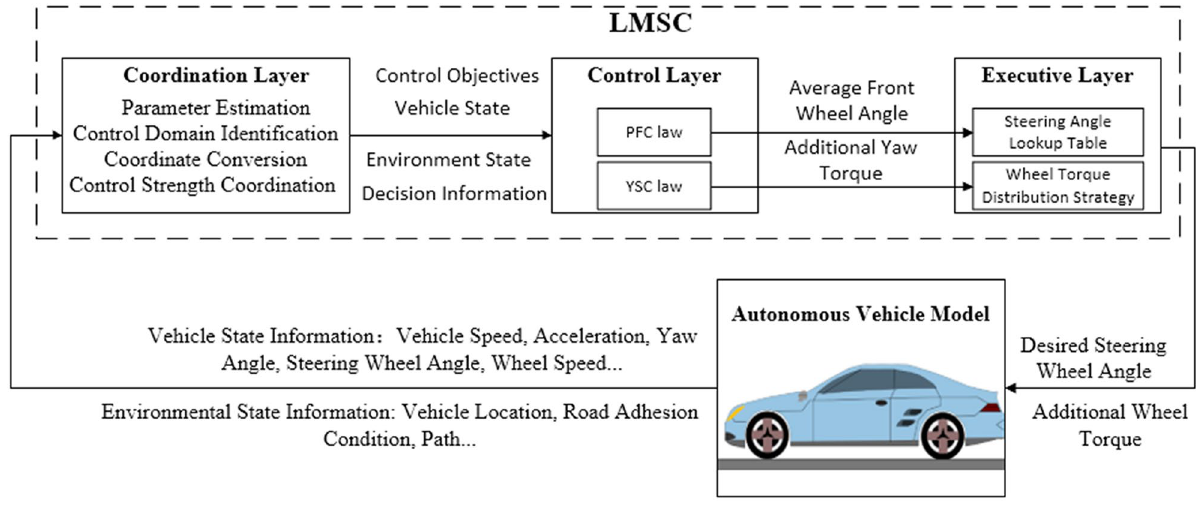
Figure 3. Layered control architecture of DDAV lateral motion control